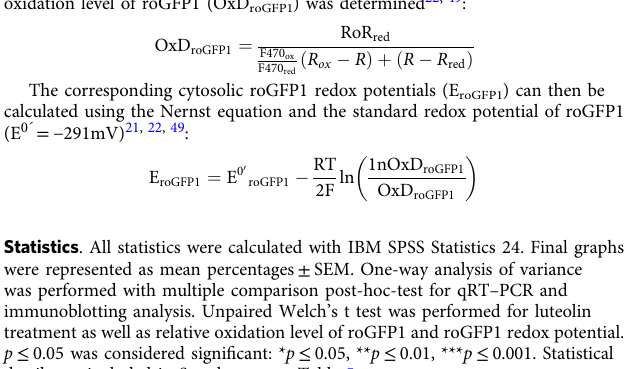
Statistics . All statistics were calculated with IBM SPSS Statistics 24. Final graphs were represented as mean percentages ± SEM. One-way analysis of variance was performed with multiple comparison post-hoc-test for qRT – PCR and immunoblotting analysis. Unpaired Welch ’ s t test was performed for luteolin treatment as well as relative oxidation level of roGFP1 and roGFP1 redox potential. p ≤ 0.05 was considered signi fi cant: * p ≤ 0.05, ** p ≤ 0.01, *** p ≤ 0.001. Statistical details are included in Supplementary Table